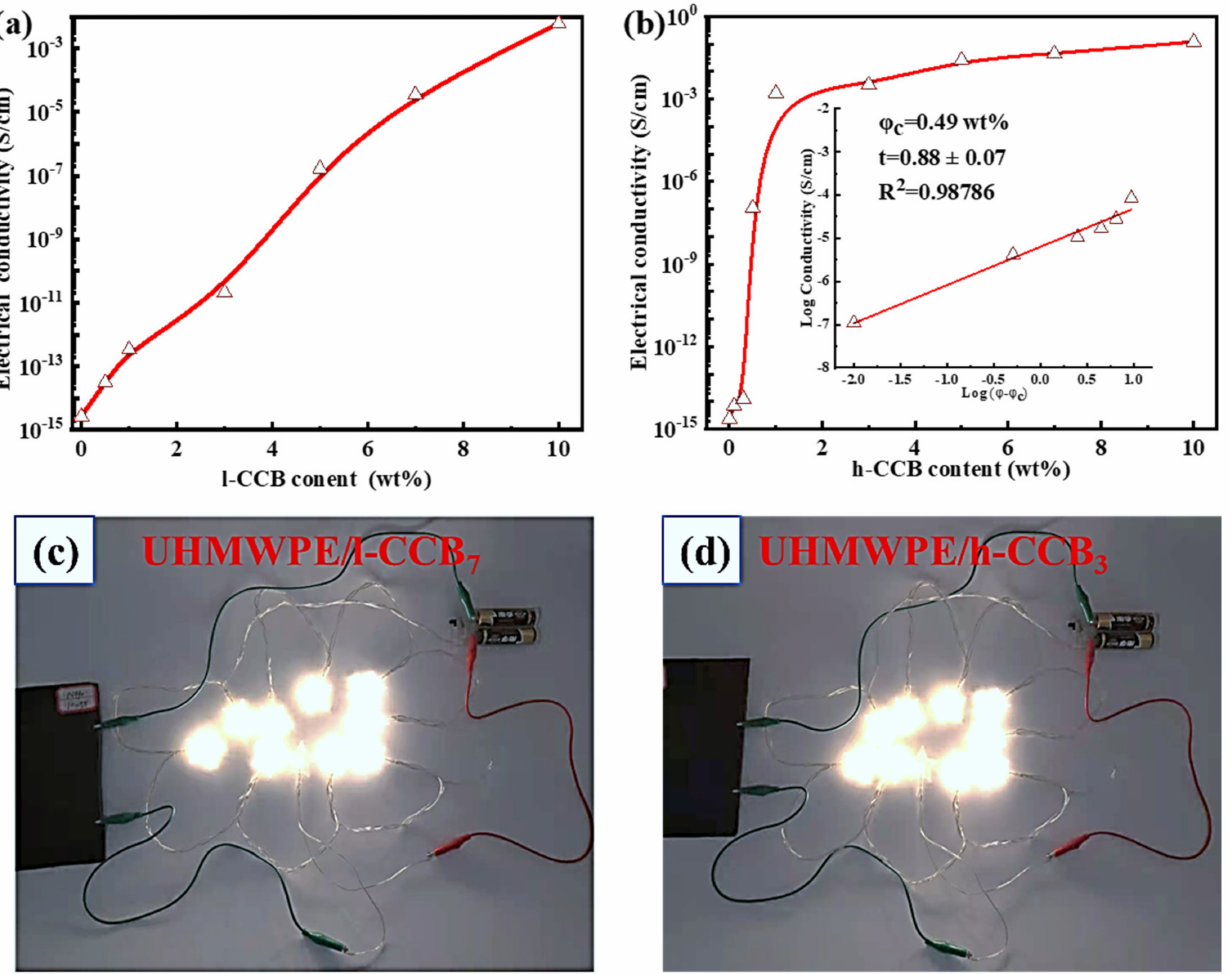
Figure 8. Comparation of σ of UHMWPE/CCB composites with the different CCB content: ( a ) UHMWPE/h-CCB; and ( b ) UHMWPE/l-CCB; the actual conductive circuit of the glowing LED bulbs energized by ( c ) UHMWPE/l-CCB 7 ; and ( d ) UHMWPE/h-CCB 3